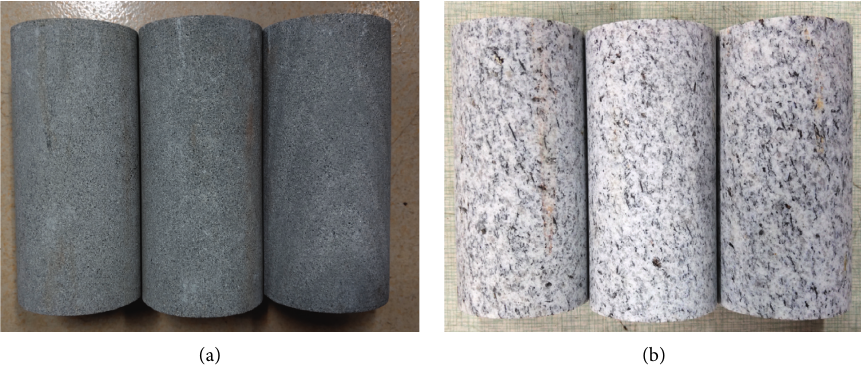
Figure 1: Rock specimens used in the cyclic loading-unloading tests of (a) Green sandstone and (b) Yueyang